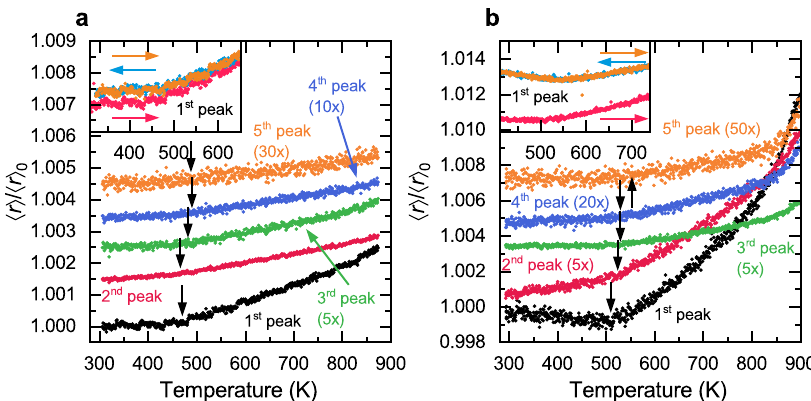
Fig. 7 Increase of the average atomic distances for the various atomic shells in QNb and QMo. All atomic shells of both a QNb and b QMo show signs of the Invar effect through a change of slope at the dilatometric transition temperature. This effect is particularly strong in the fi rst atomic shell and gets stronger after relaxation. The higher-order peak positions are shifted for clarity. The same nominal increase of atomic distances becomes proportionally less signi fi cant at higher-order atomic shells; the relative changes of average atomic distances are thus scaled for better readability. The insets show the heating and cooling runs for the fi rst atomic shell, where the heating runs differ from each other due to structural relaxation at the end of the fi